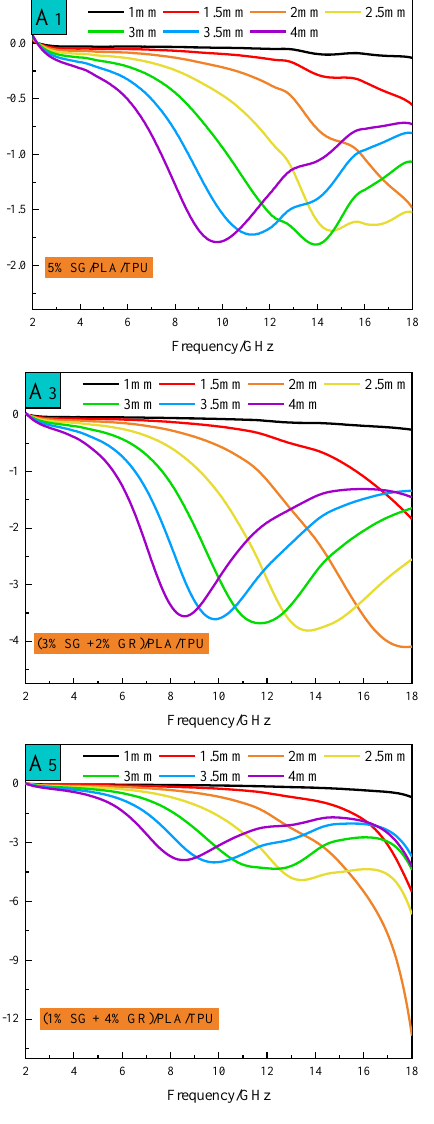
Figure 8. Variation curves of reflectivity with frequency of A 1 ~A 6 composites with different thicknesses. The reflectivity peaks of A 1 ~A 6 composites all moved to low frequency with the increase of absorbing thickness, which can be explained by quarter-wave theory and Formula (4) [27 – 29].